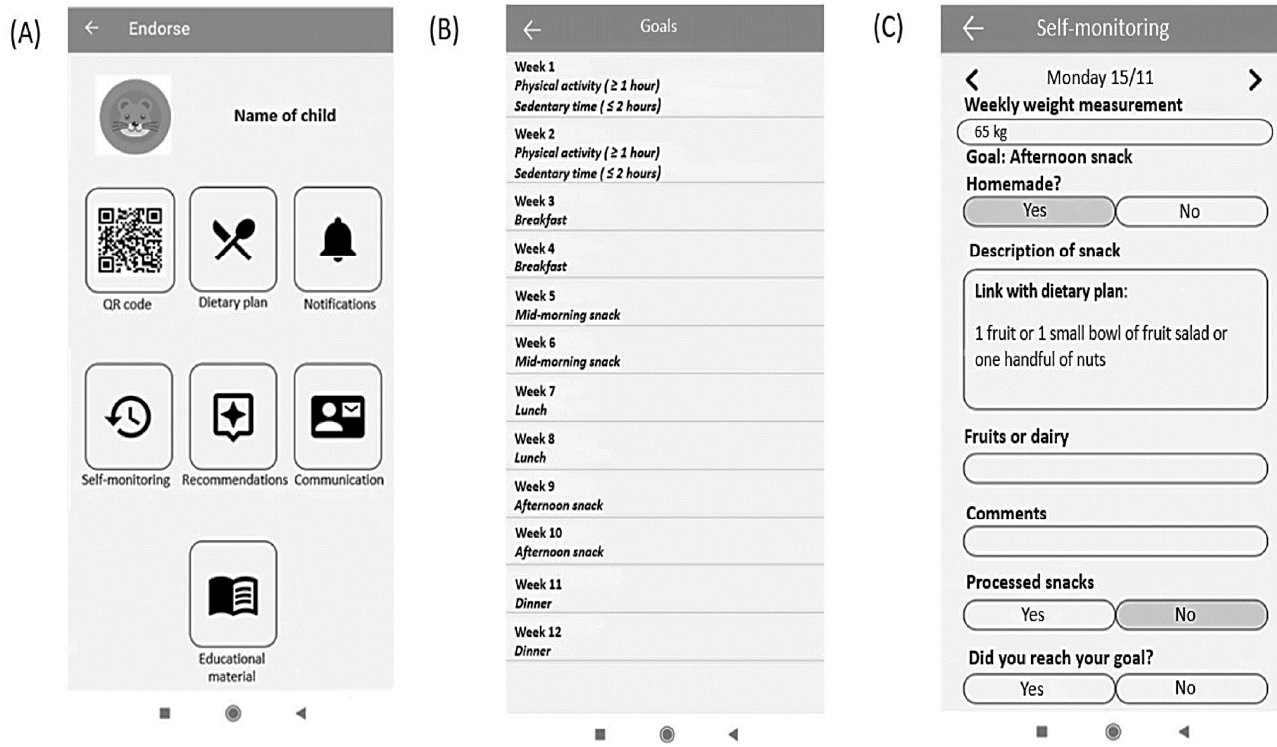
Figure 2. User interface of the parental version of the ENDORSE mobile application: ( A ) initial screen of the ENDORSE application, ( B ) summary of behavioral goals, and ( C ) example of self-monitoring of weight and health behavior goals [35].